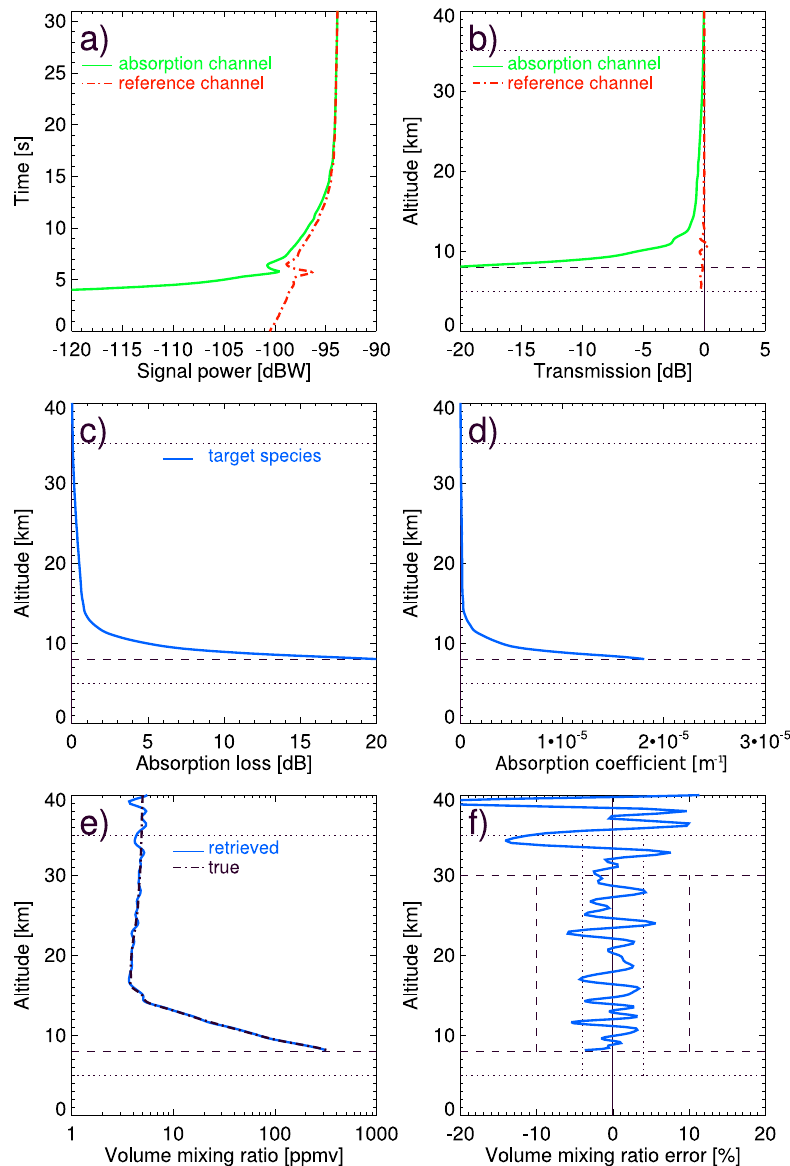
Fig. 5. Illustration of the single-line trace species retrieval (SSR) algorithm for the single-line species H 2 O(2). The layout is the same as in Fig. 4; see that caption for